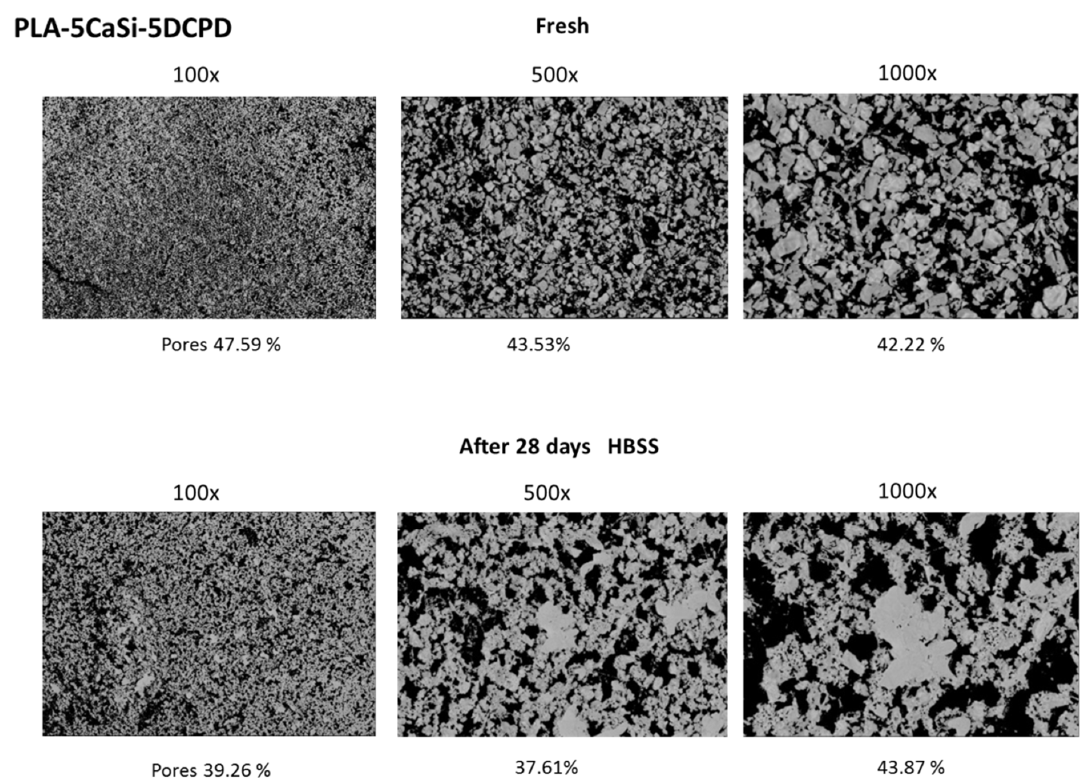
Figure 5. ESEM surface micromorphology of PLA-5CaSi-5DCPD scaffold. An overall decrease of surface pores was observed at all magnifications, attributable to the mineral layer deposition upon immersion in HBSS.